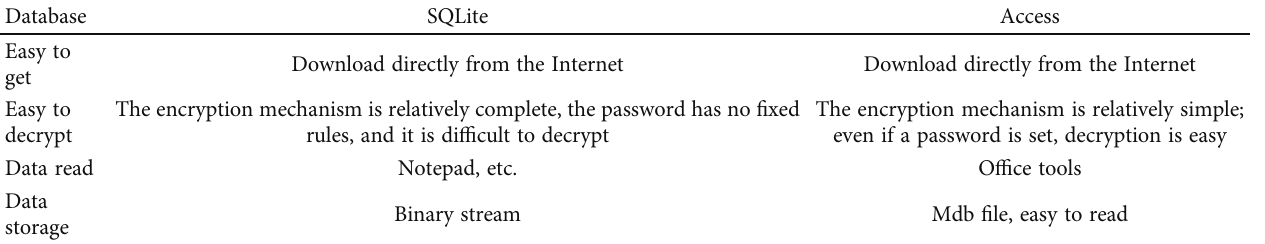
Figure 5: CN1010 crosscompilation diagram. Table 1: Compare experimental results.